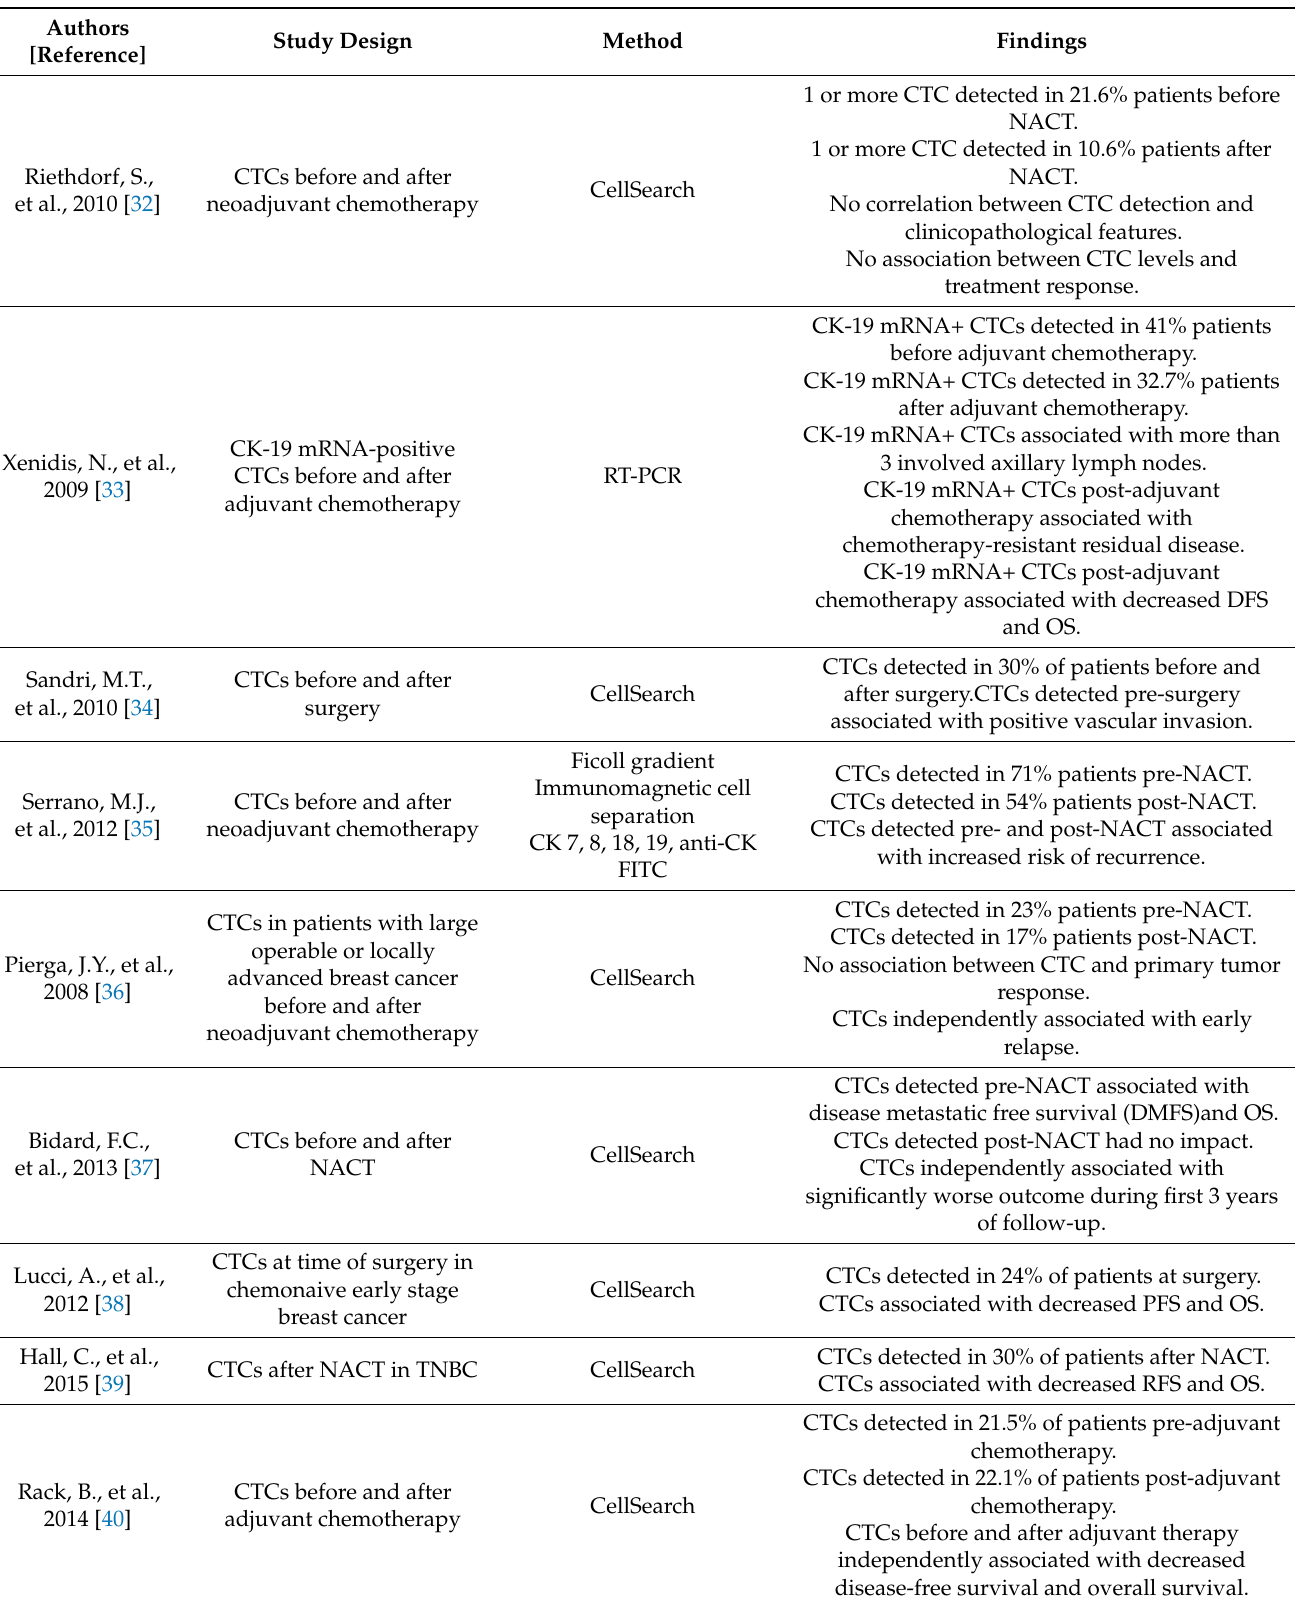
Table 1. CTCs in early breast